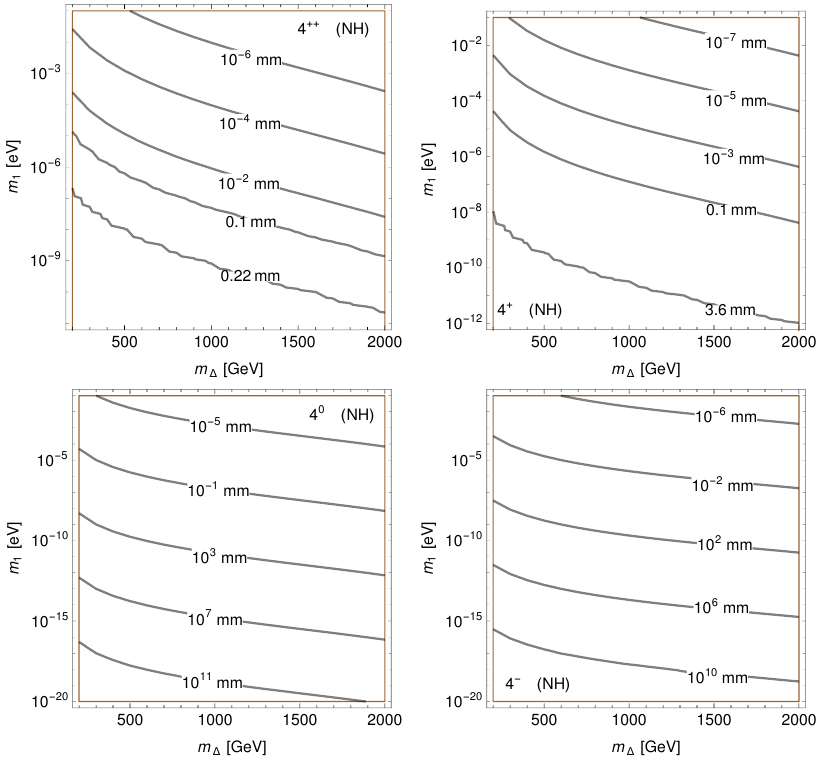
Figure 14 . Contour plots for decay length in ( m 1 − M χ ) plane for 4 ++ , 4 + , 4 0 and 4 − , respectively, for normal hierarchical light neutrino mass spectrum.